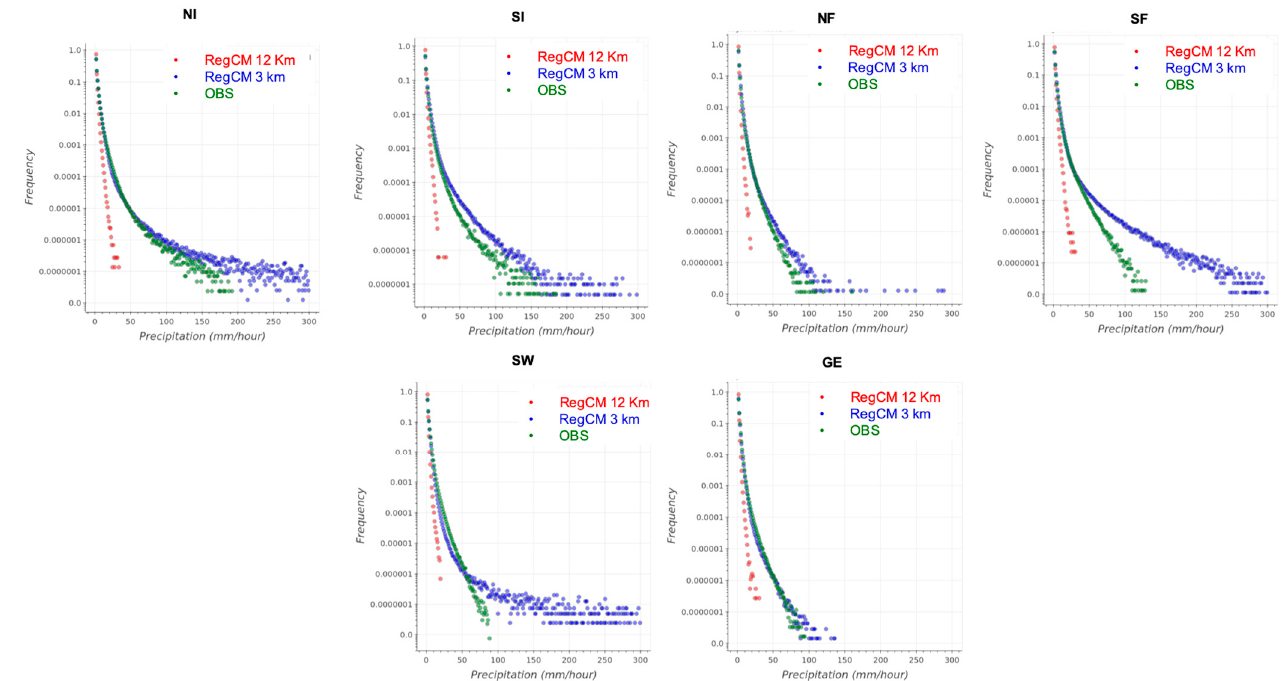
Figure 14. Similar to Figure 13, but for hourly precipitation. The observations are composed from available gridded hourly precipitation over North and South Italy (NI, SI) (GRIPHO [76]), North and South France (NF, SF) (COMEPHORE [8]), Switzerland (SW) (RADKLIM [74]), and Germany (GE) [75].